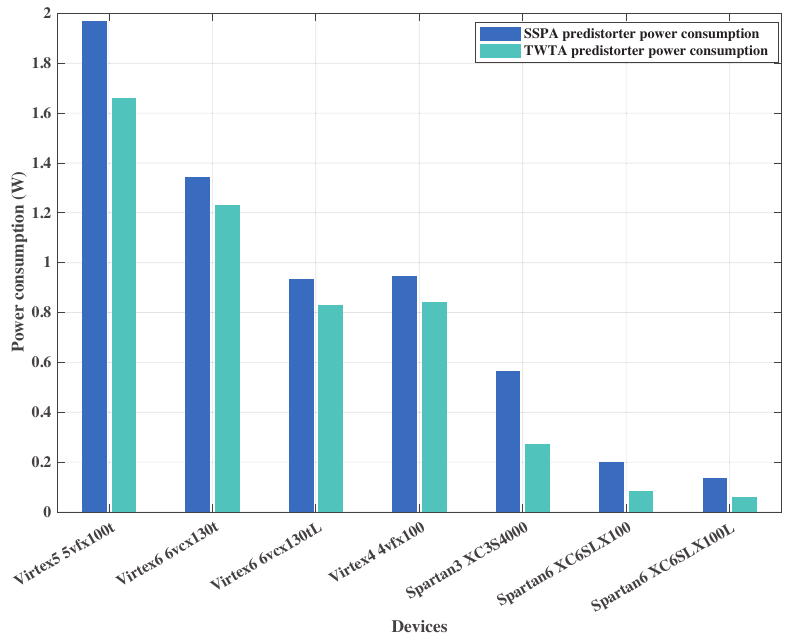
Figure 11. Power consumption For both SSPA and TWTA pre-distorter implementation.